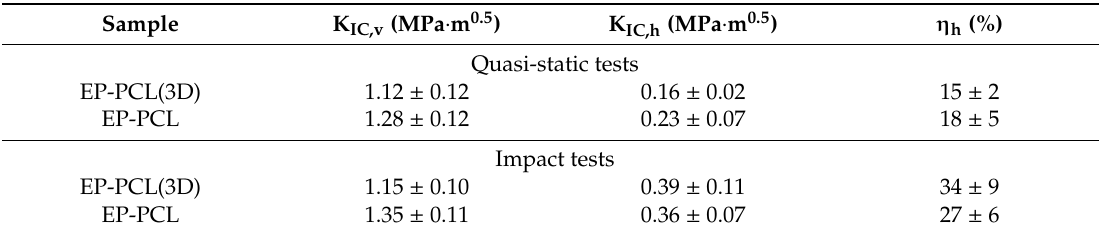
Figure 6. Representative load–displacement curves of ( a ) EP-PCL(3D) and ( b ) EP-PCL samples (healed and not healed) obtained in fracture toughness tests under quasi-static conditions. Table 3. Healing e ffi ciency values of EP-PCL(3D) and EP-PCL samples under quasi-static and impact